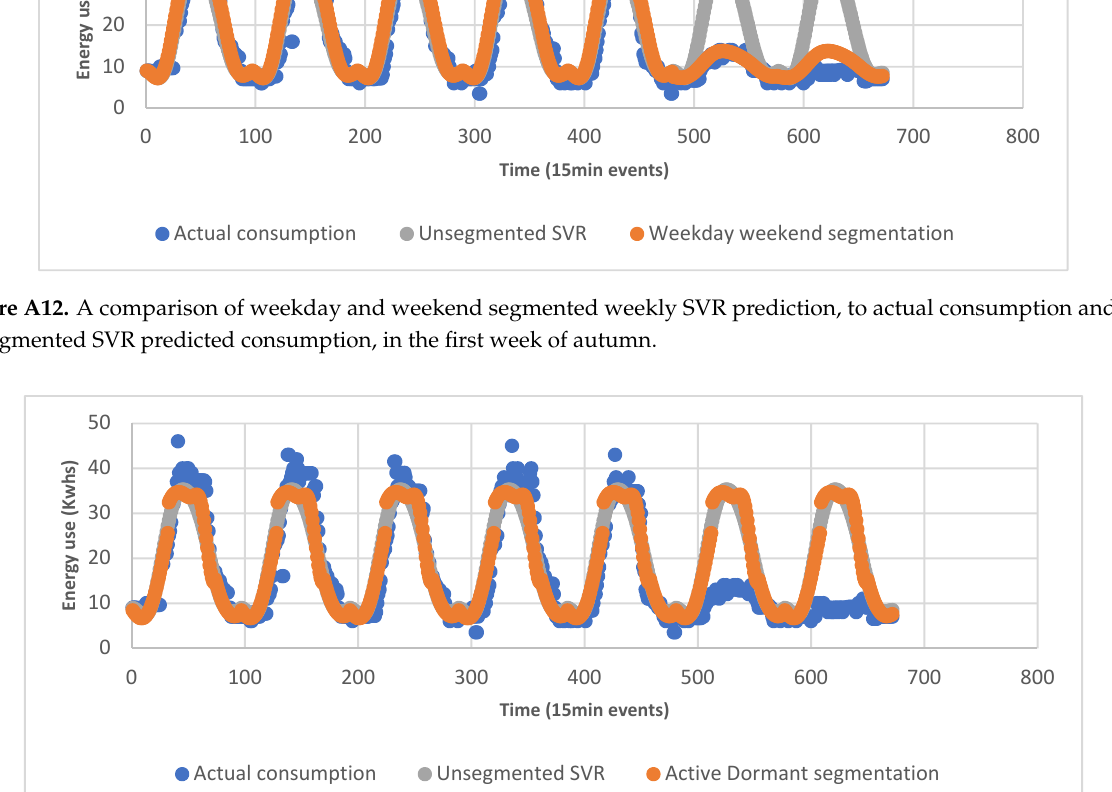
Figure A13. A comparison of building active and dormancy period segmented weekly SVR prediction, to actual consump- tion and the unsegmented SVR predicted consumption, in the first week of autumn.